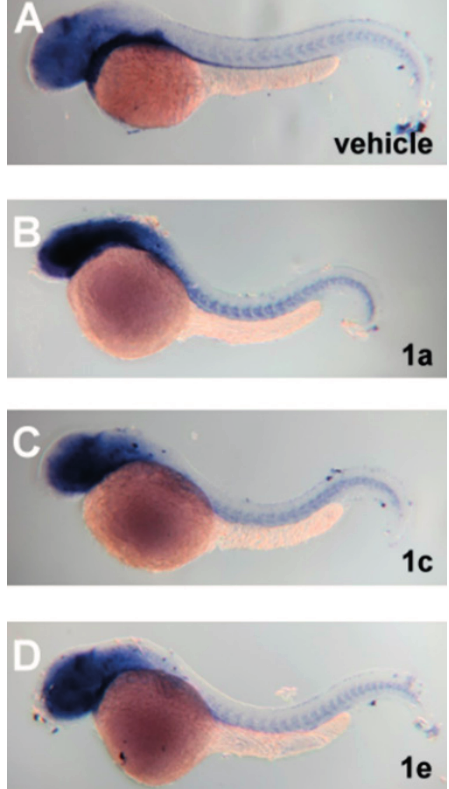
Figure 6. Effects of chalcone derivatives on the expression of vegfaa 165 .Whole-mount in situ hybridization was utilized to analyze the expression of vegfaa 165 in zebrafish embryos treated with DMSO vehicle ( A ); 3 ppm of compound 1a ( B ); 1c ( C ) or 1e ( D ) via exposure method I. Embryos at 36 hpf were subjected to whole-mount in situ hybridization. All figures were lateral views with anterior to the left and dorsal at the